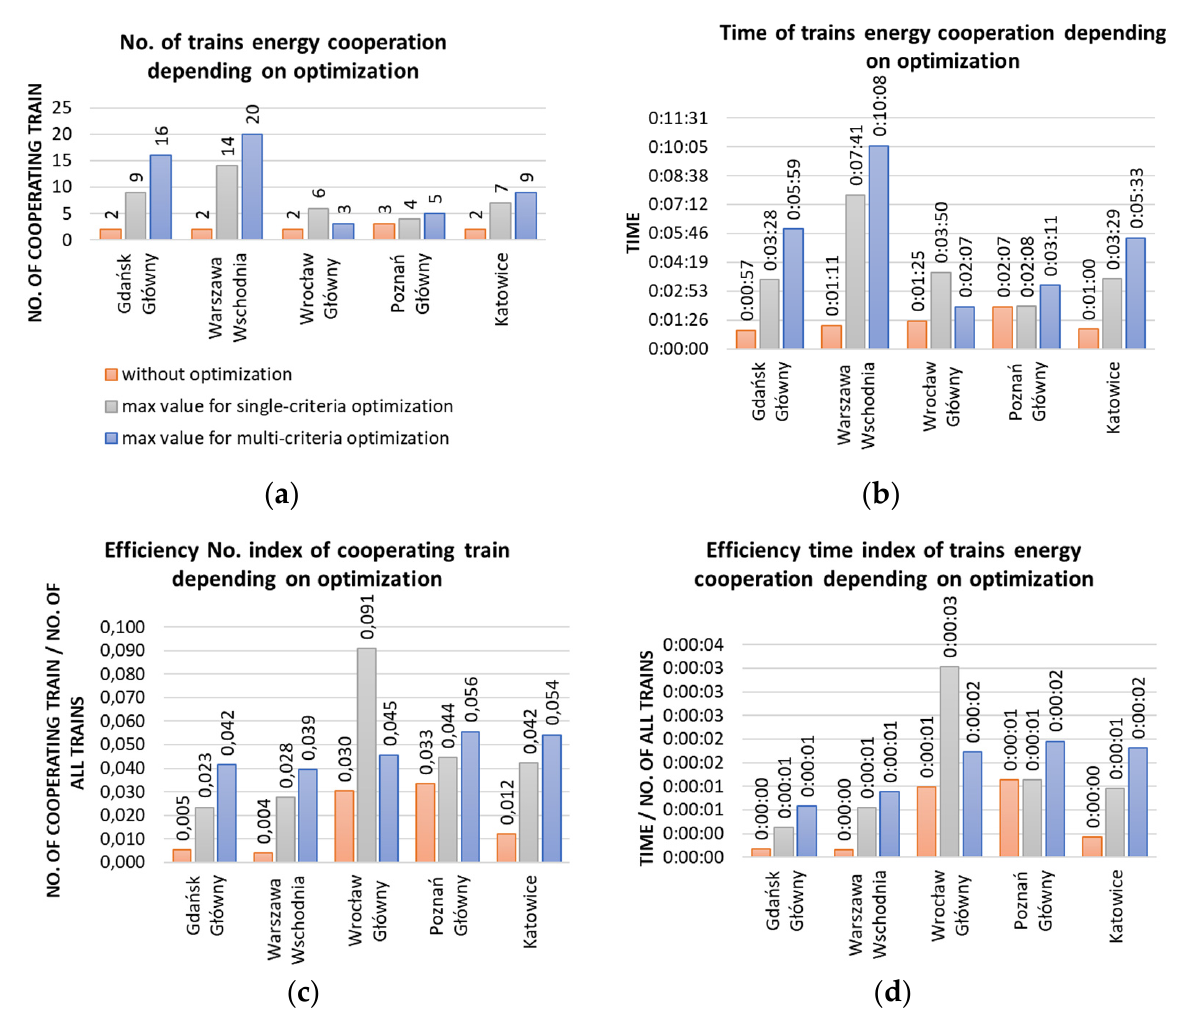
Figure 8. Summary of the final results depending on the optimization used. ( a ) No. of trains energy cooperation depending on optimization. ( b ) Time of trains energy cooperation depending on optimization. ( c ) Efficiency No. index of cooperating train depending on optimization. ( d ) Efficiency time index of trains energy cooperation depending on optimization. Source: own study.